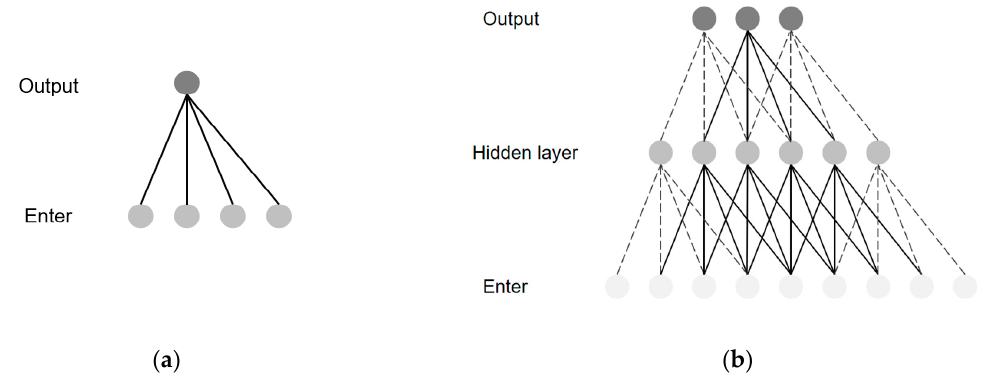
Figure 1. Causal convolution. ( a ) A single causal convolution structure, and ( b ) the overall structure.